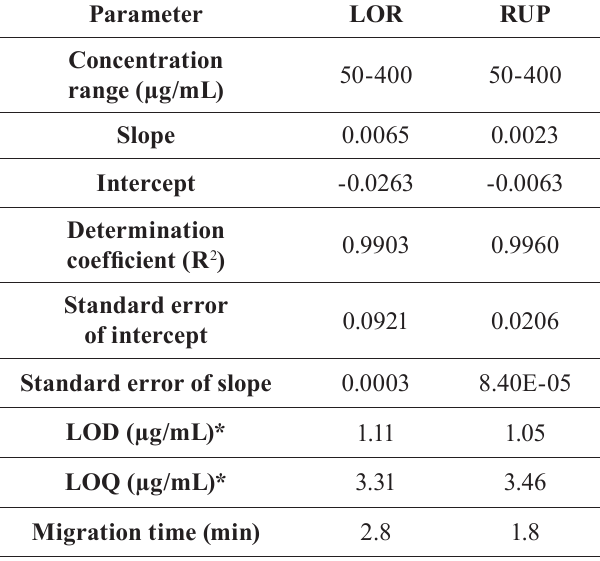
TABLE III - The linear regression data, LOD, LOQ for LOR, and